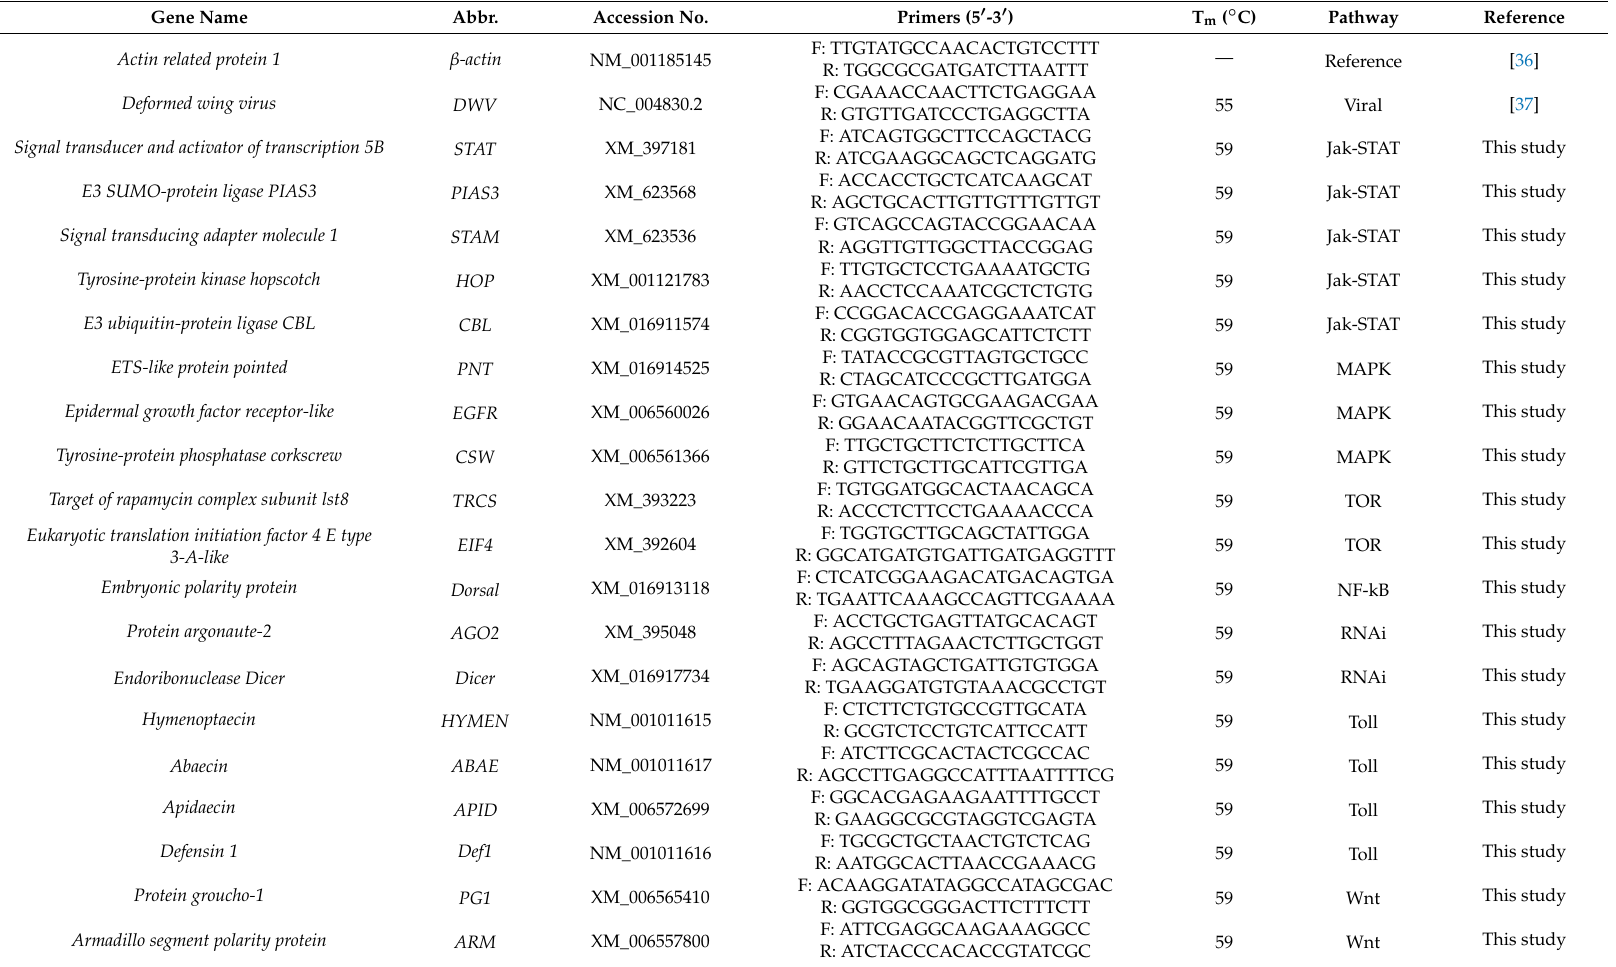
Table 1. Primers used for qRT-PCR in this